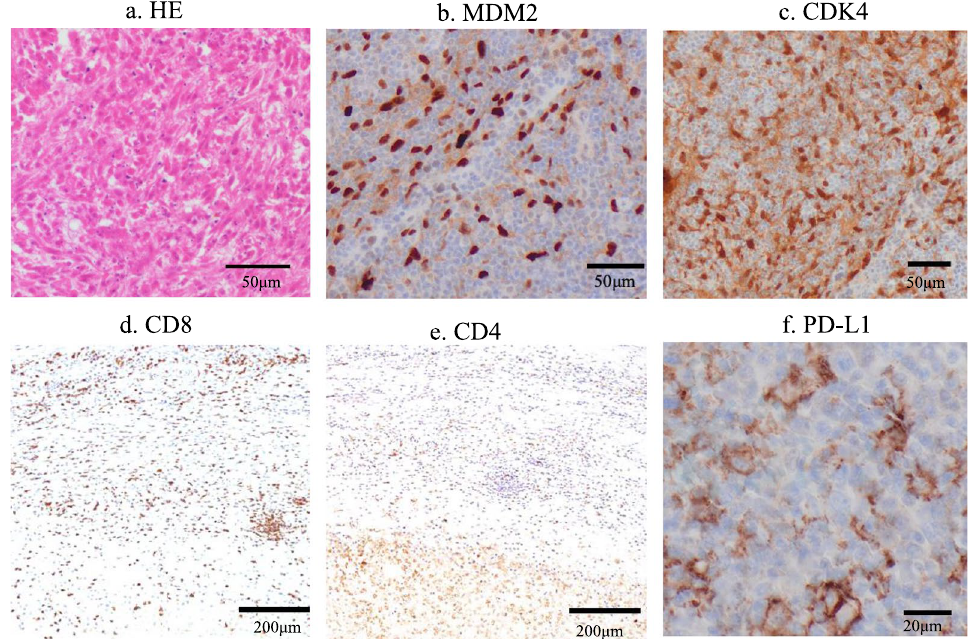
Fig. 3 Microscopic and immunohistochemical findings. a HE-staining showing dedifferentiated liposarcoma with necrotic foci. b , c Tumor cells around necrotic tissue showing high MDM2 and CDK4-expression in the resected margin. d , e CD8 immunostaining. f 90% of tumor cells were positive for PD-L1 by